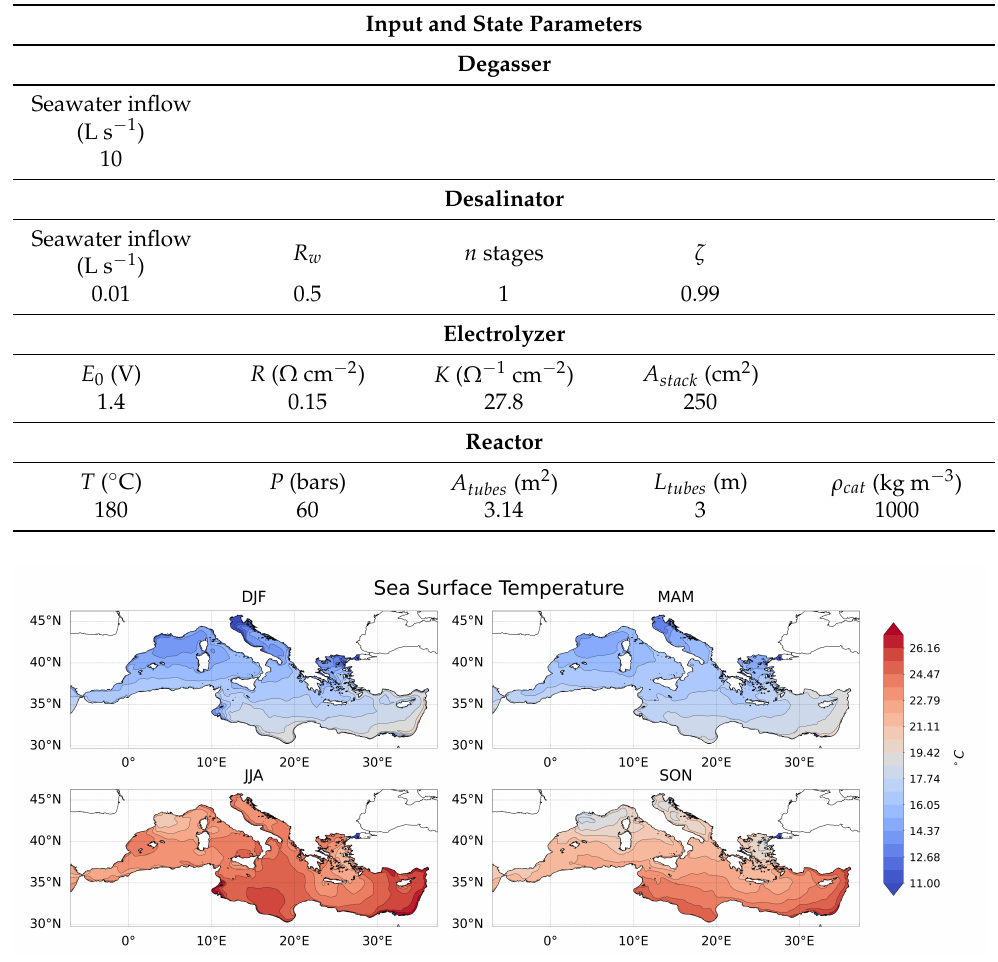
Figure 15. Seasonally averaged sea surface temperature from the NEMO simulation